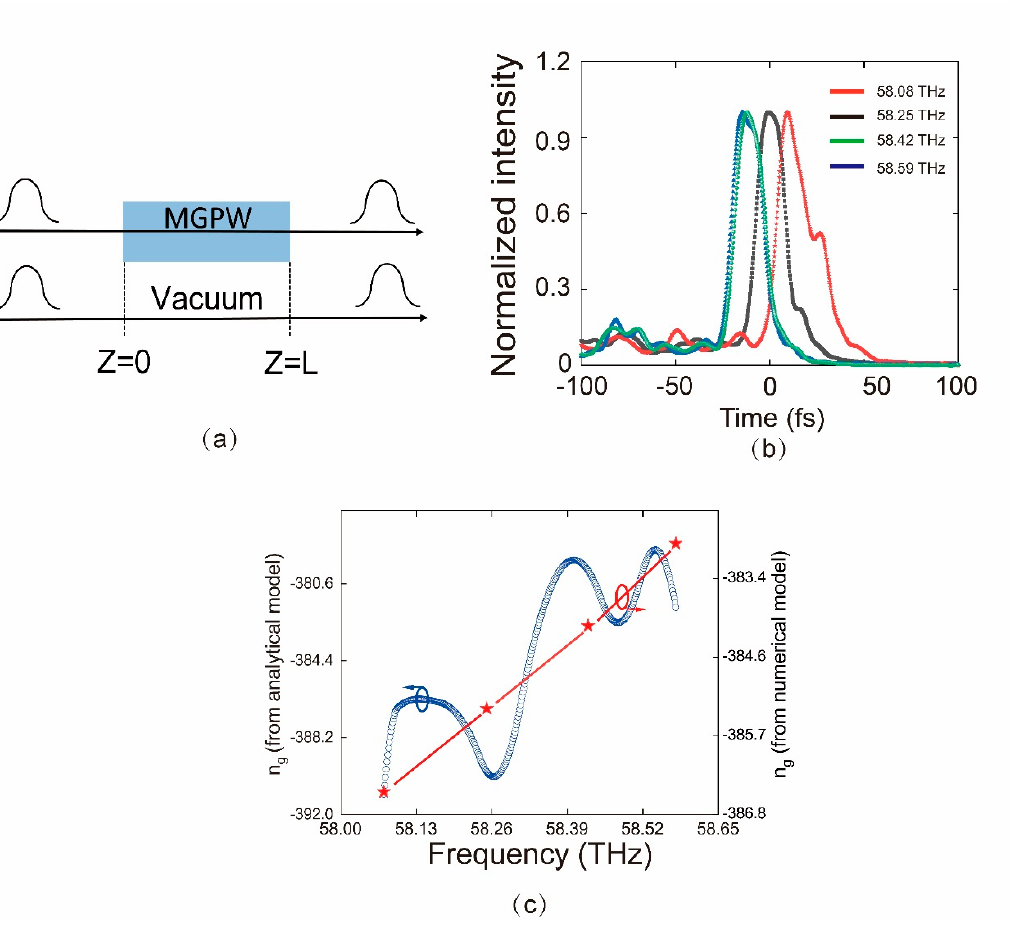
Figure 6. Distinction between backward propagation, forbidden band and forward propagation. ( a ) Transmittance of backward propagation, forbidden band and forward propagation; ( b – d ) are the light field of backward propagation, forbidden band and forward propagation, respectively. The pitch of the metamaterial in ( a – c ) is 1040 nm × 770